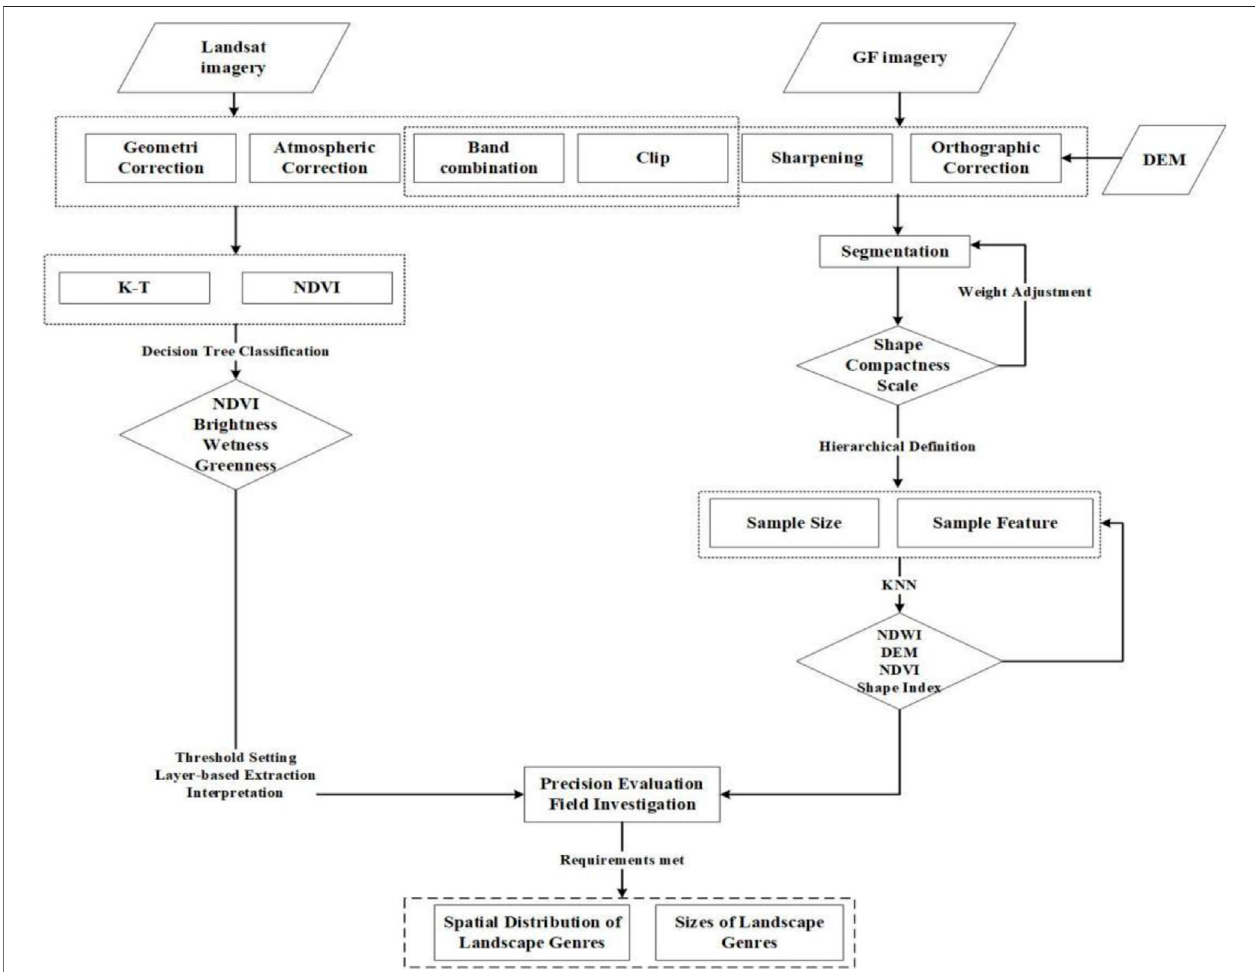
FIGURE 4 | Diagram of Sanmen Bay ’ s landscape genres in 1995, 2005, 2015, and 2020.